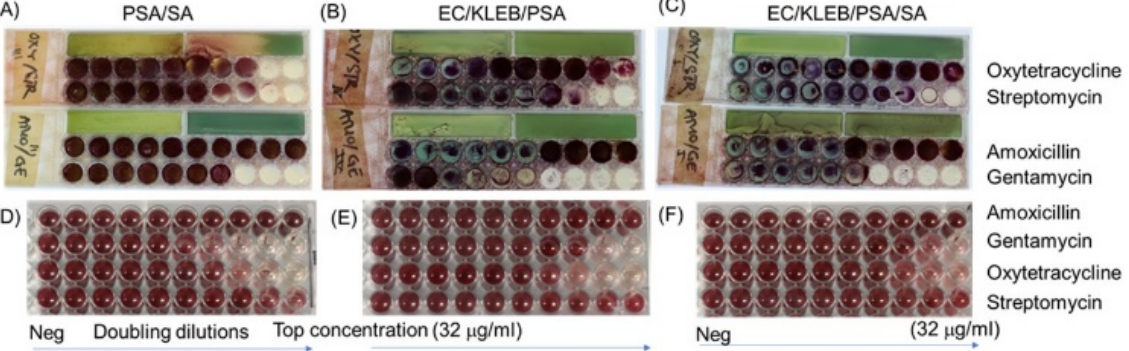
Figure 7. Antibiotic susceptibility by agar dilution for mixtures of microbes, simulating multiple organisms present in some samples . Mixtures of the following strains were prepared and split for testing in parallel using 3D-printed multiplex millifluidic dip slides ( A – C ) vs. conventional microplate broth microdilution ( D – F ). Naming of microbial species: Pseudomonas aeruginosa (PSA), Staphylococcus aureus (SA), E. coli (EC), Klebsiella spp. (KLEB).